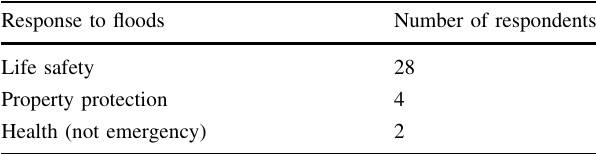
Table 7 Distribution of concepts in the category ‘‘Response to floods’’ in the Akuressa area of Sri Lanka Response to